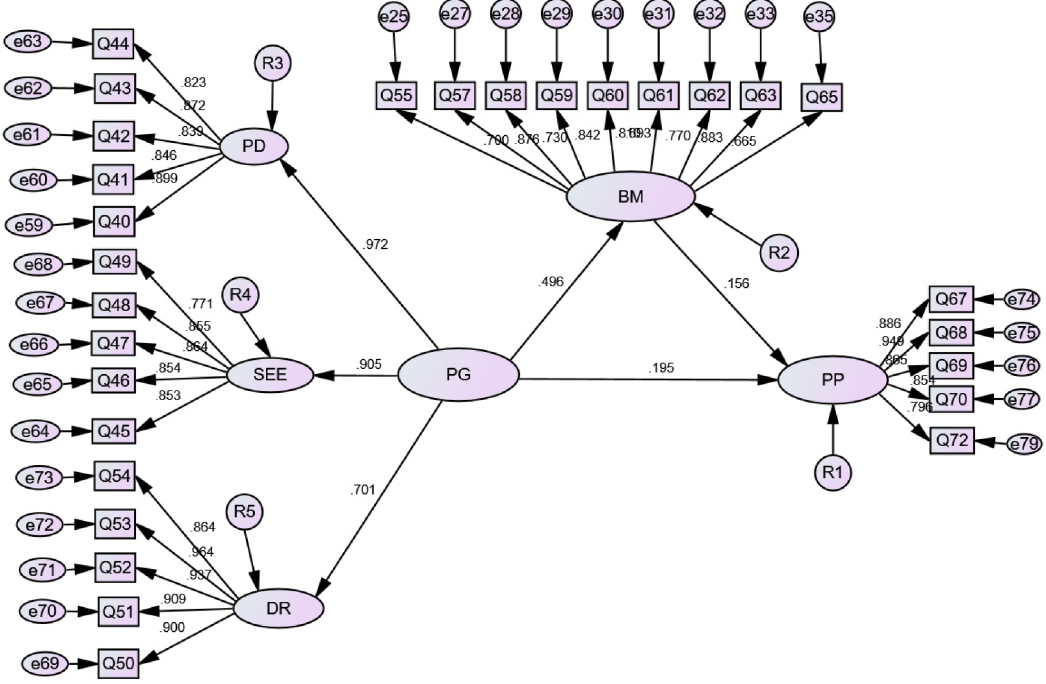
Figure 2. Structural